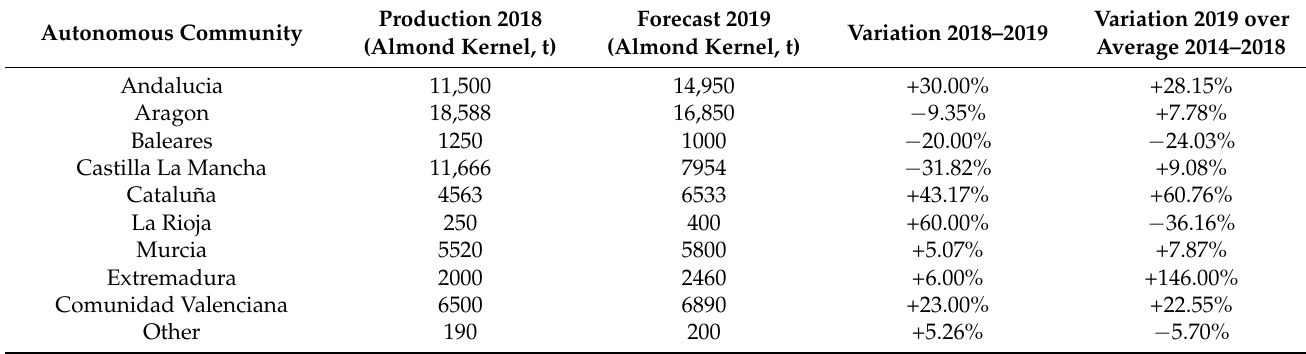
Table 1. Almond production estimation for 2019/2020 campaign in Spain.